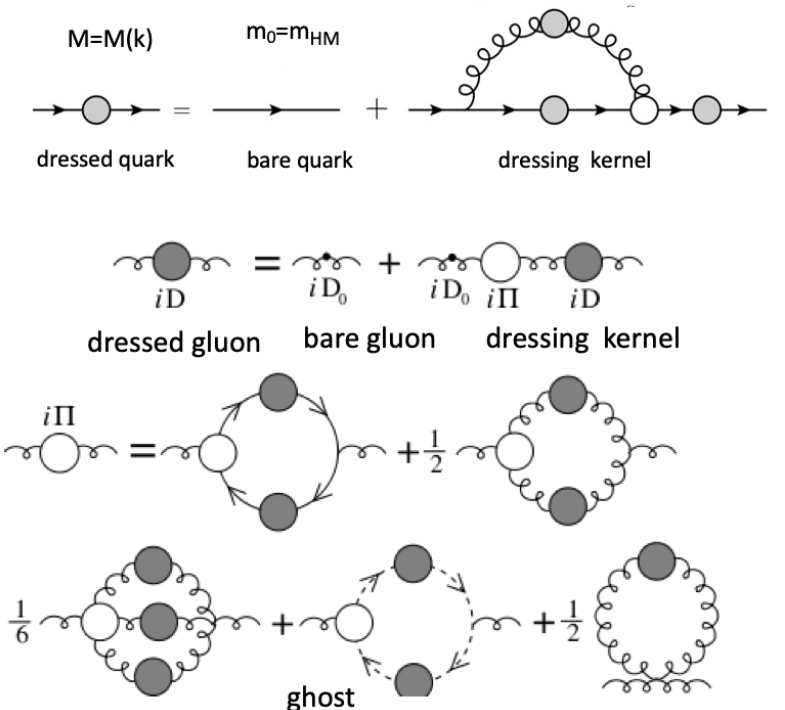
Figure 1. Integral equations for the dressed quark and gluon two-point functions [84] (Section 2.2), drawn in terms of the Feynman diagrams that govern the emergence of gluon and quark quasiparticles from the partons used to express the QCD Lagrangian. (Total momentum k flows from left to right in each diagram, being conserved in passing through the loop integrals.) These quasiparticles are the active components in hadron structure at low resolving scales. Their parton content is revealed at higher resolutions. (Unbroken lines—quarks; spring-like lines—gluons; short-dashed lines—ghosts; filled circles—dressed propagators; open circles—two-point = self-energies and three/ four-point = dressed vertices. The vertices satisfy their own Dyson–Schwinger equations, involving higher n -point functions